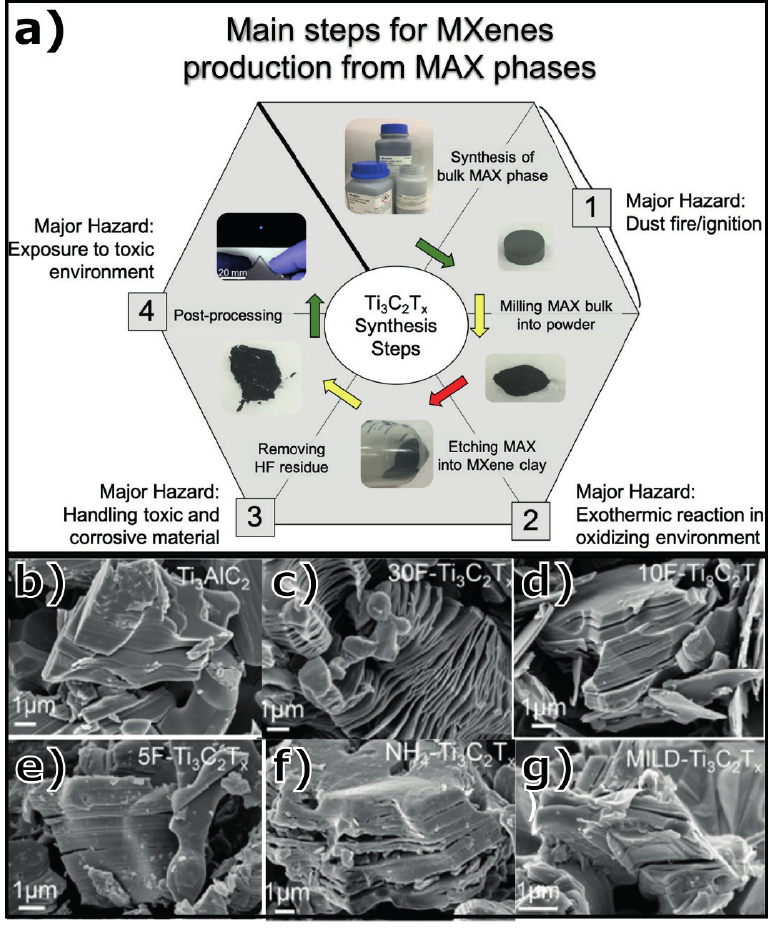
Figure 5. Schematic representation of MXene production from raw